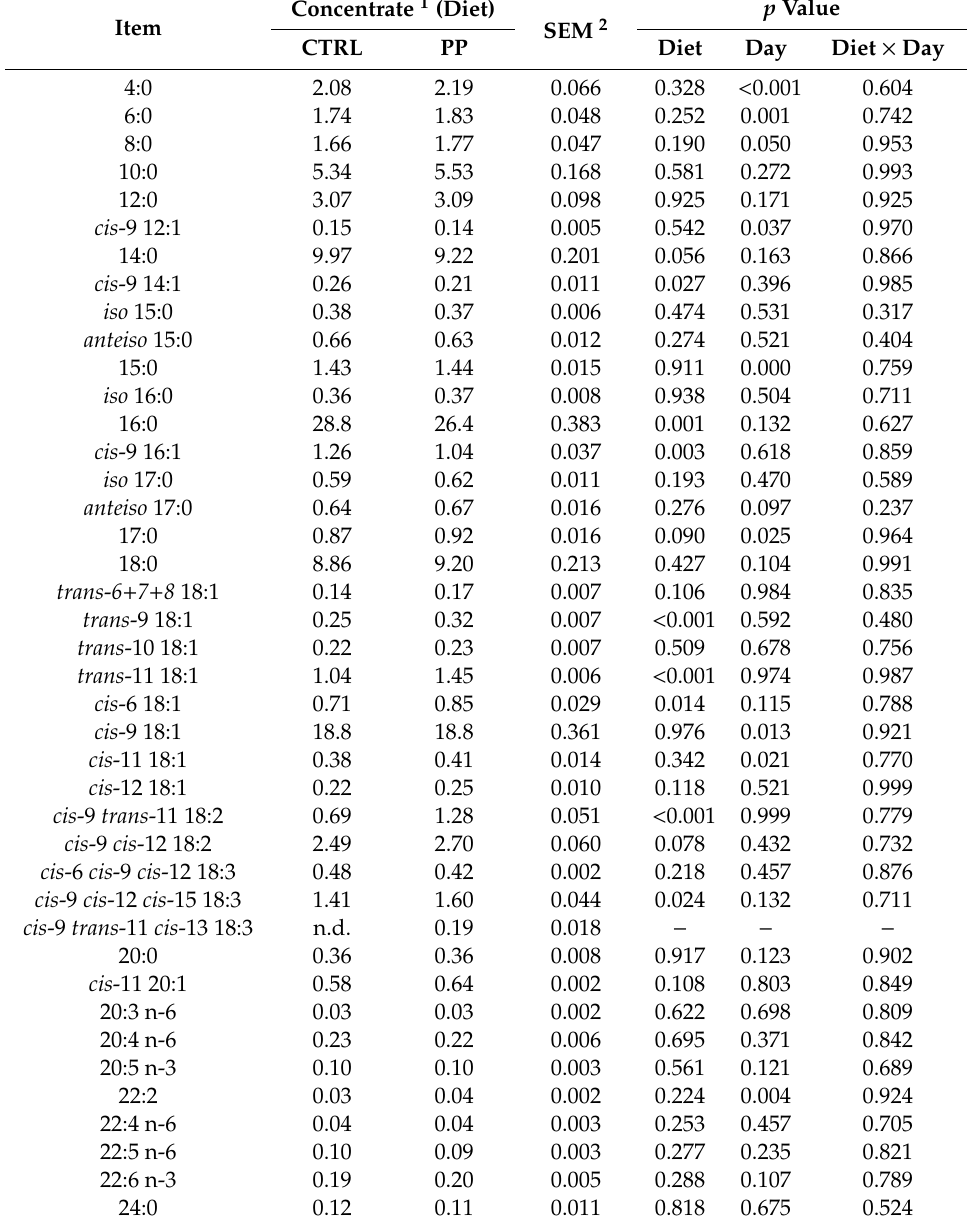
Table 3. E ff ect of the inclusion of pomegranate pulp in the diet of lactating ewes on milk fatty acids expressed as g / 100 g of total fatty